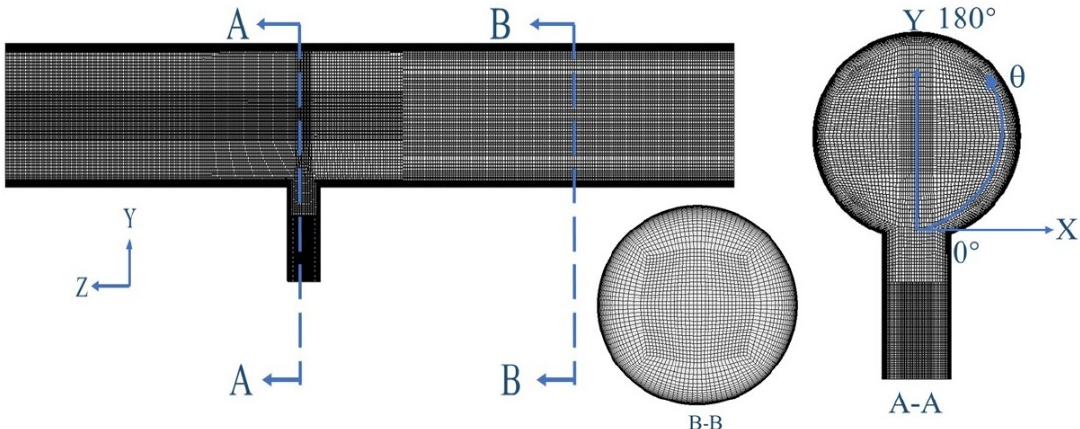
Figure 2. Schematic diagram of the computational mesh.